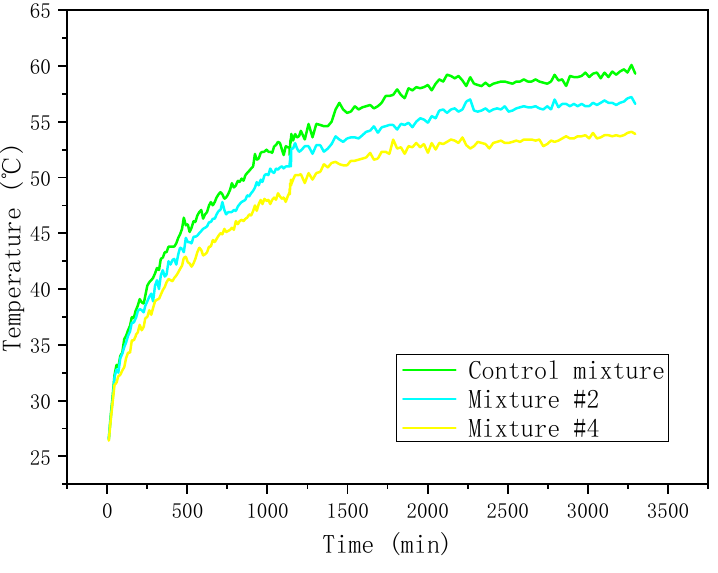
Figure 13. Surface temperature evolution.